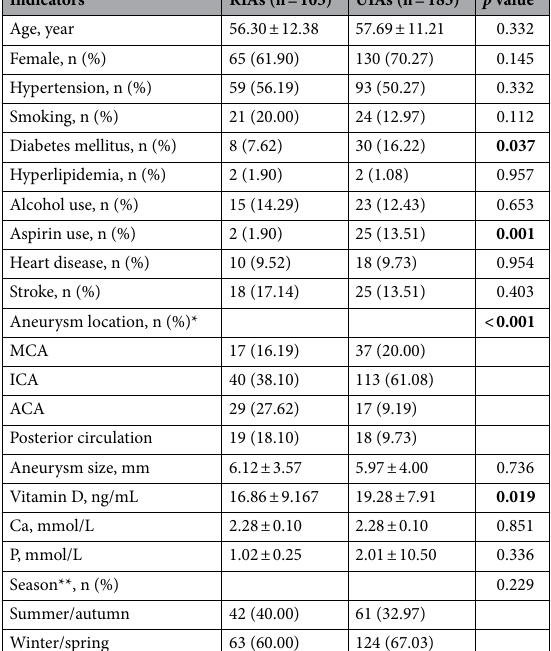
Table 1. Demographic and clinical characteristics of patients with IAs at baseline. Bold: p < 0.05. * MCA middle cerebral artery, ICA internal carotid artery, ACA anterior cerebral artery. **The season of blood collection was defined as “summer/autumn” (December to May), “winter/spring” (June to